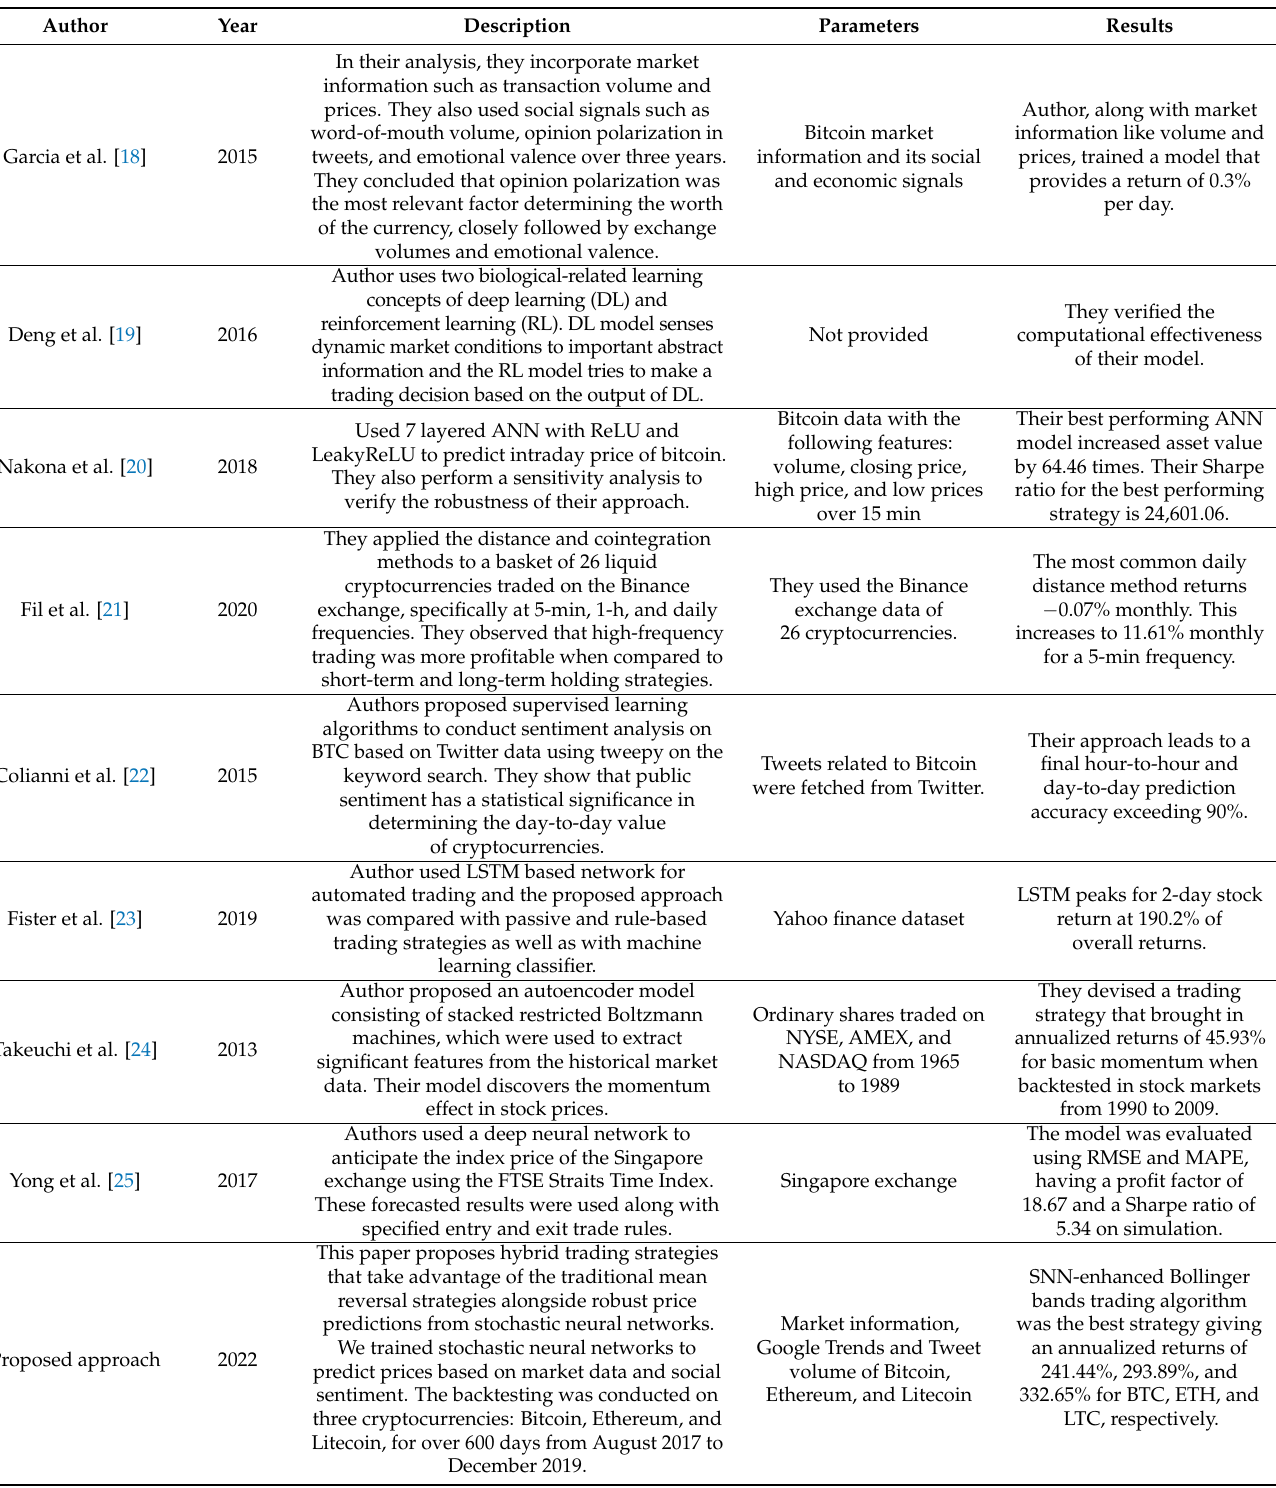
Table 1. A relative comparison of recent work in the field of trading of